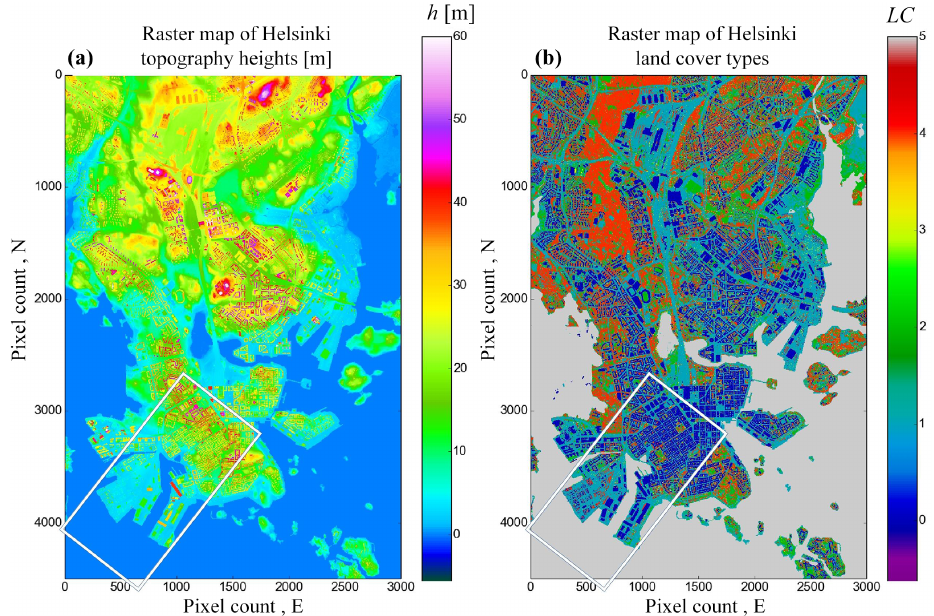
Figure 1. Raster maps of topography height h (a) and land cover types LC (b) from Helsinki area. The rectangle in the bottom left corner is aligned with southwesterly wind and represents the area of interest for the footprint analysis. In the surface type classification each pixel (2m) is categorized according to the following numbering: 0 = building, 1 = impervious (rock, paved, gravel), 2 = grass, 3 = low vegetation, 4 = high vegetation, and 5 =